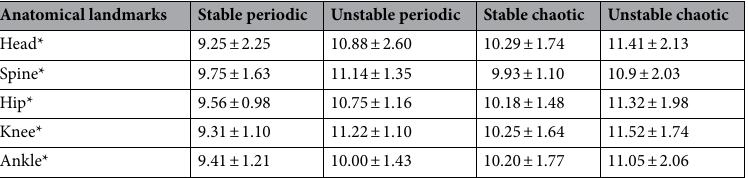
Table 1. Short-term maximum Lyapunov exponents of the four examined postural tasks of varying surface (stable-rigid and unstable-foam) and target complexity (periodic-sinusoidal and chaotic-Lorenz) for every analysed anatomical landmark. Values are presented in mean ± standard deviation. *Significant surface effect (stable vs. unstable surface) (p <